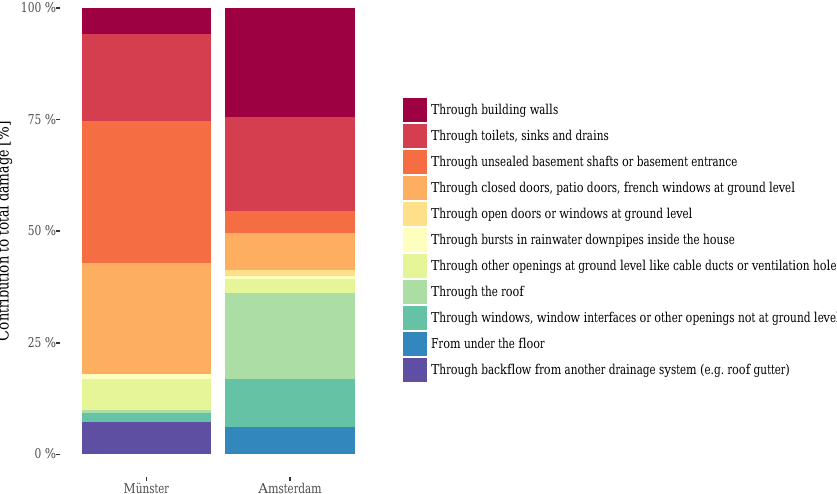
Figure 5. The different ways water entered a house and their relative contribution to the total damage (of all data). Damage was assigned to the pathways as follows: if a respondent only reported one pathway, then the damage amount was completely assigned to that pathway. If two or more pathways were reported at the same time, then the damage amount was equally divided over these pathways.